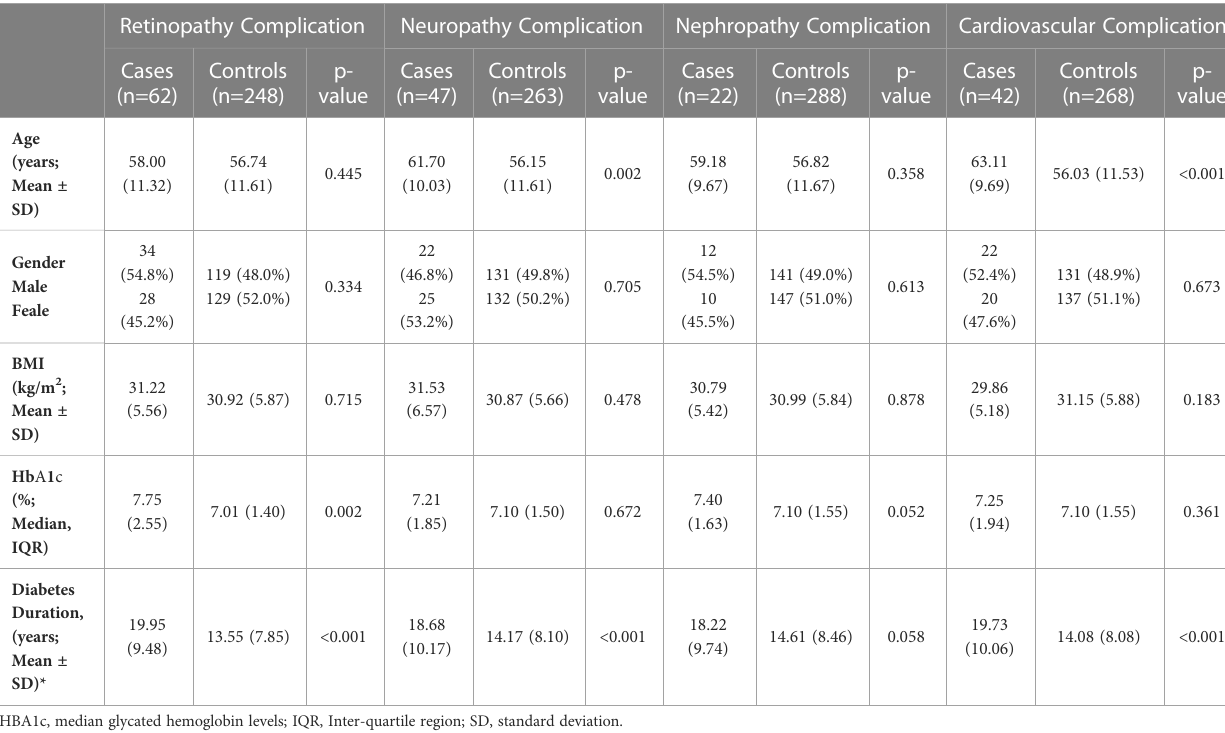
TABLE 1 Demographic factors of the